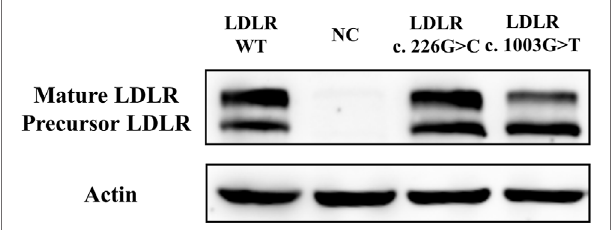
FIGURE 3 | The effect of LDLR variants on LDLR expression.